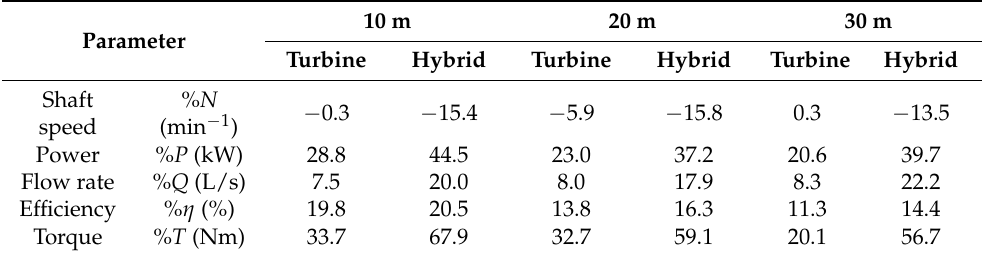
Table 4. Relative increases of the performance parameters at BEP related to the